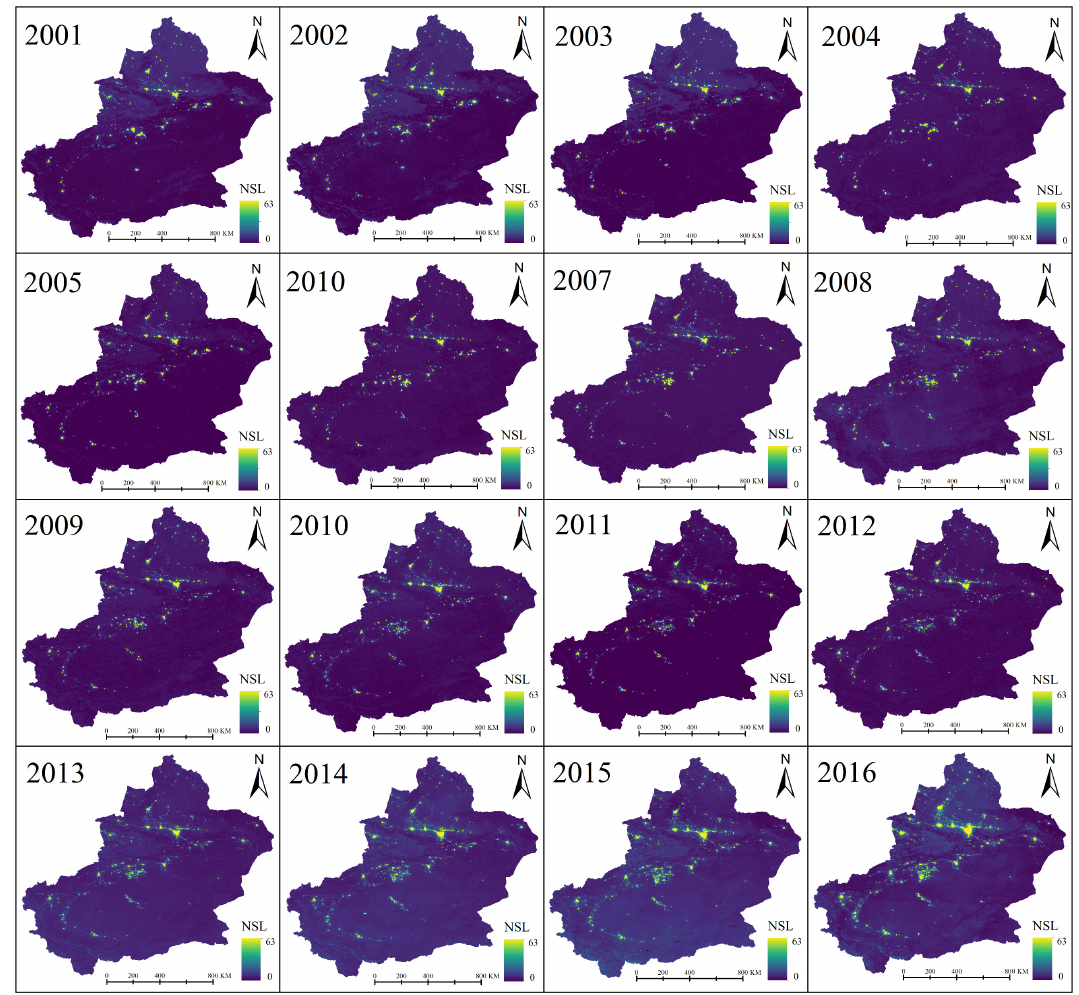
Figure 11. Spatial distributions of annual average NSL in Xinjiang from 2001–2016.